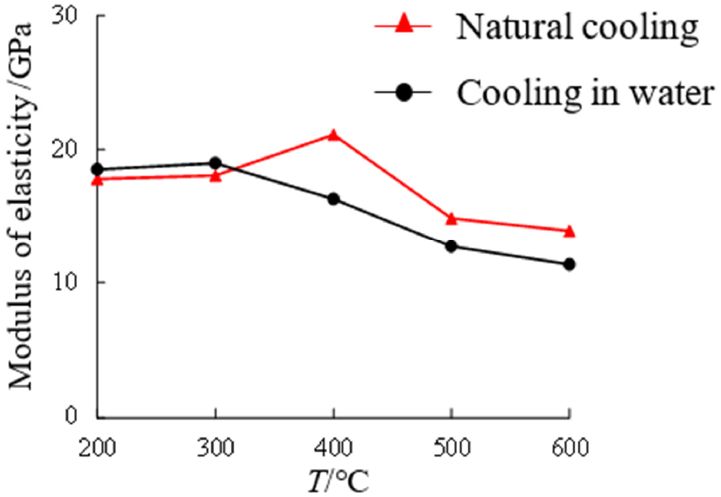
Figure 9. Change of elastic modulus of samples after different cooling methods.